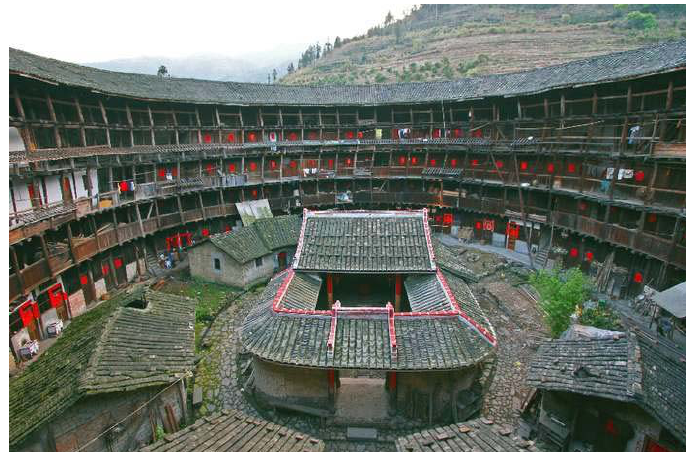
Figure 40. Tulou rooms